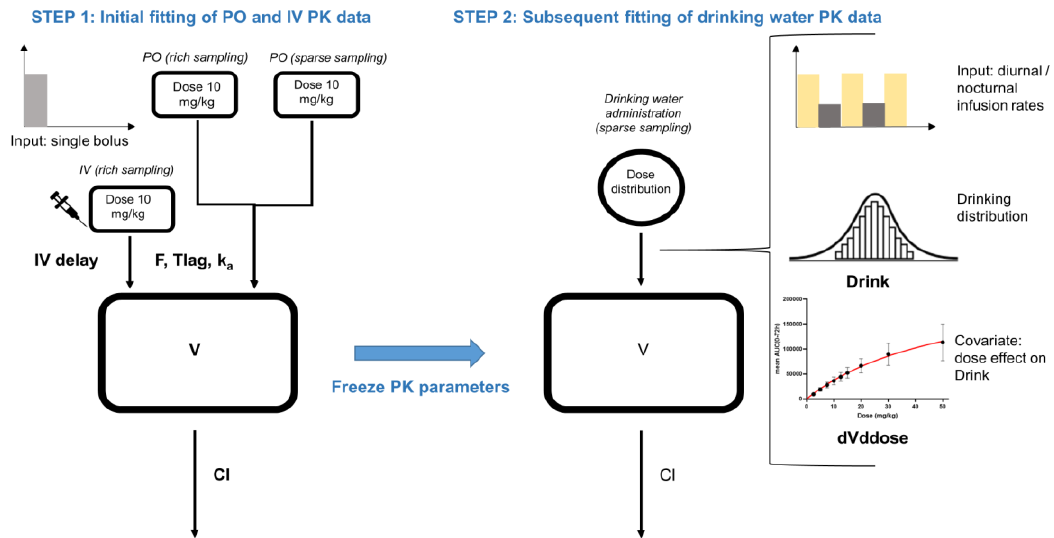
Figure 1. An overview of the PK modelling process. Using the data of the IV and PO single bolus administration (rich and sparsely sampled) animal trials, the parameters of the one-compartment model (Cl, V, Ka and F with an additional IV delay and Tlag) were estimated and subsequently fixed in further analyses. In order to model the drinking water administration modality and develop the DBPK model, three model improvements were implemented. First, diurnal and nocturnal infusion rates were chosen in order to mimic the drinking behaviour during the photo- and scoto-period, respectively. Second, the variability in drinking water behaviour and therefore in bioavailability was captured using an additional parameter, Drink. Third, accounting for the nonlinear relationship between dose and exposure, a covariate was introduced (dVddose) to decrease Drink and hence bioavailability proportionally with higher doses. Table 1. Population primary (thetas) parameters of enrofloxacin in broilers obtained via sequential modelling and their associated standard error (SE), the lower and upper bounds of the 95% confidence interval (CI) and the estimated between-subject variability (BSV). First, the IV and PO data were fitted with a one-compartment model with IV delay and Tlag functions. Second, the drinking water PK data was added and the parameters Drink and dVddose were estimated. Typical Values